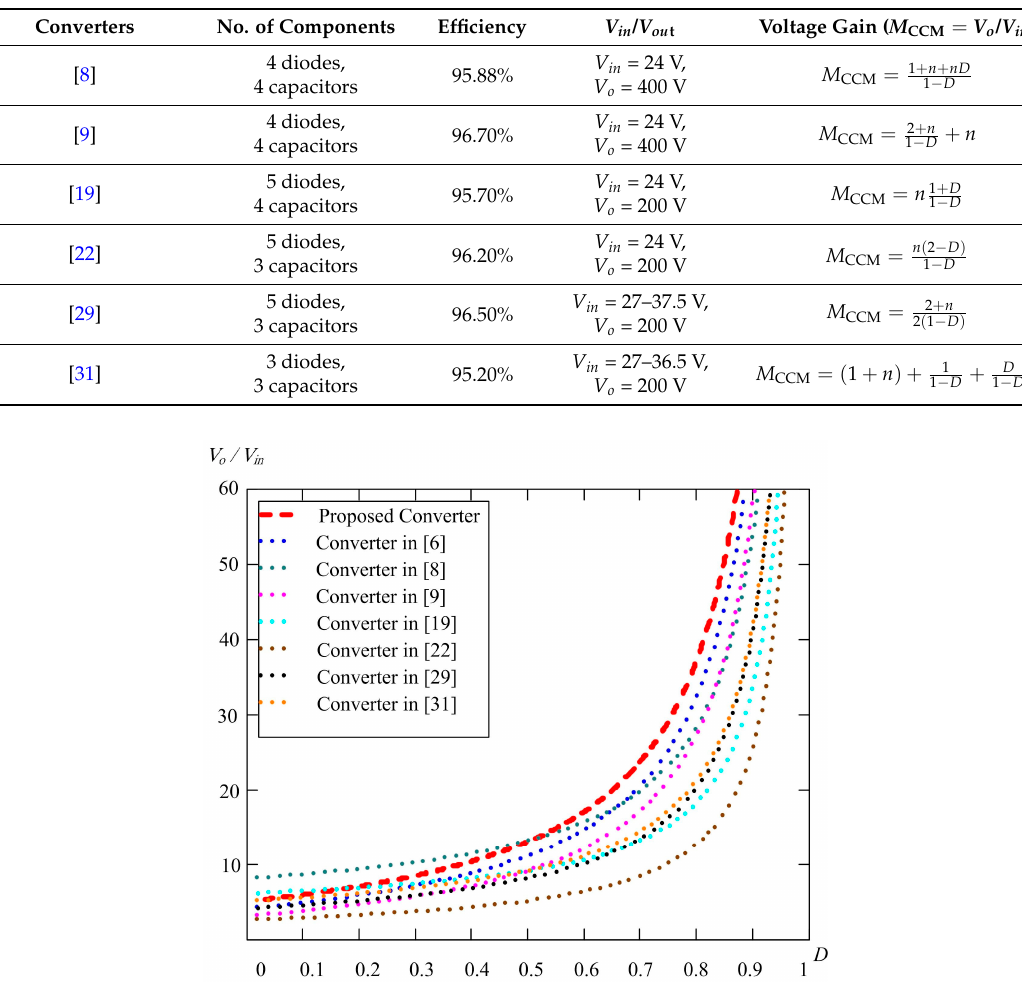
Figure 7. Duty ratio versus voltage gain of the proposed converter compared with previous converters, condition is CCM operation under k = 1 and n =